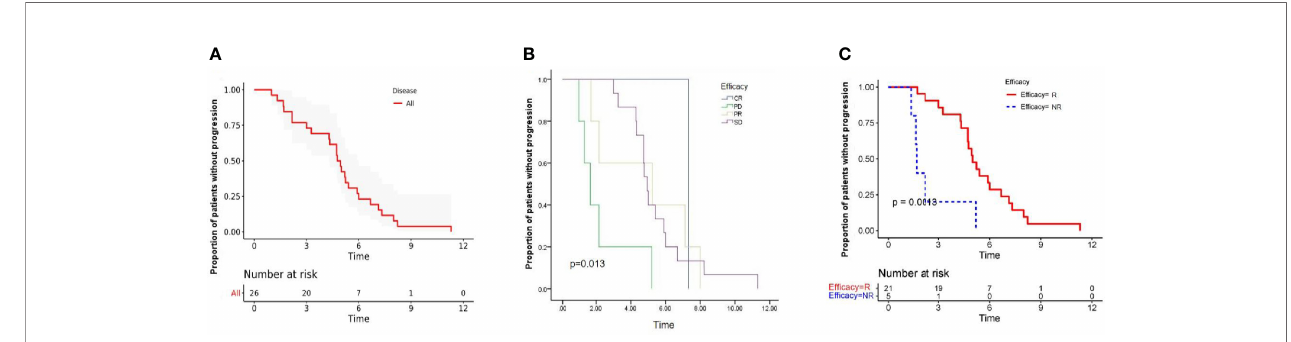
FIGURE 3 | Kaplan-Meier estimates of progression-free survival in all patients (A) , and strati fi ed by the ef fi cacy (B) . Progression free survival was signi fi cantly lower among responder group than non-responder group (C) , Long rank test was performed. P value is shown in the graphs. CR, complete response; PR, partial response; SD, stable disease; PD, progressive disease; R, responder;